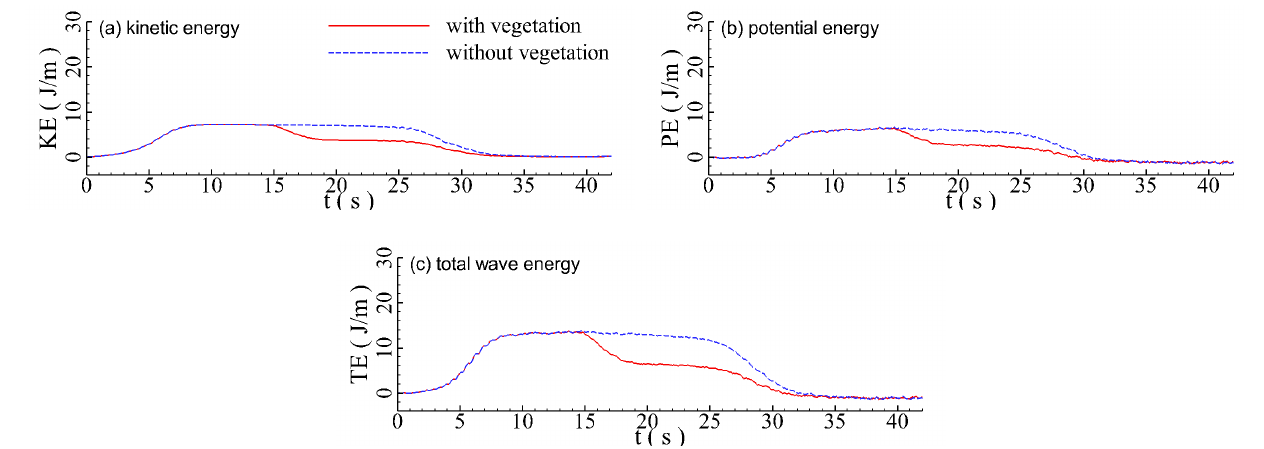
Figure 10. Energy flux at different locations. Figure 11. Time series of the wave energies of water body. Figure 11. Time series of the wave energies of water body.